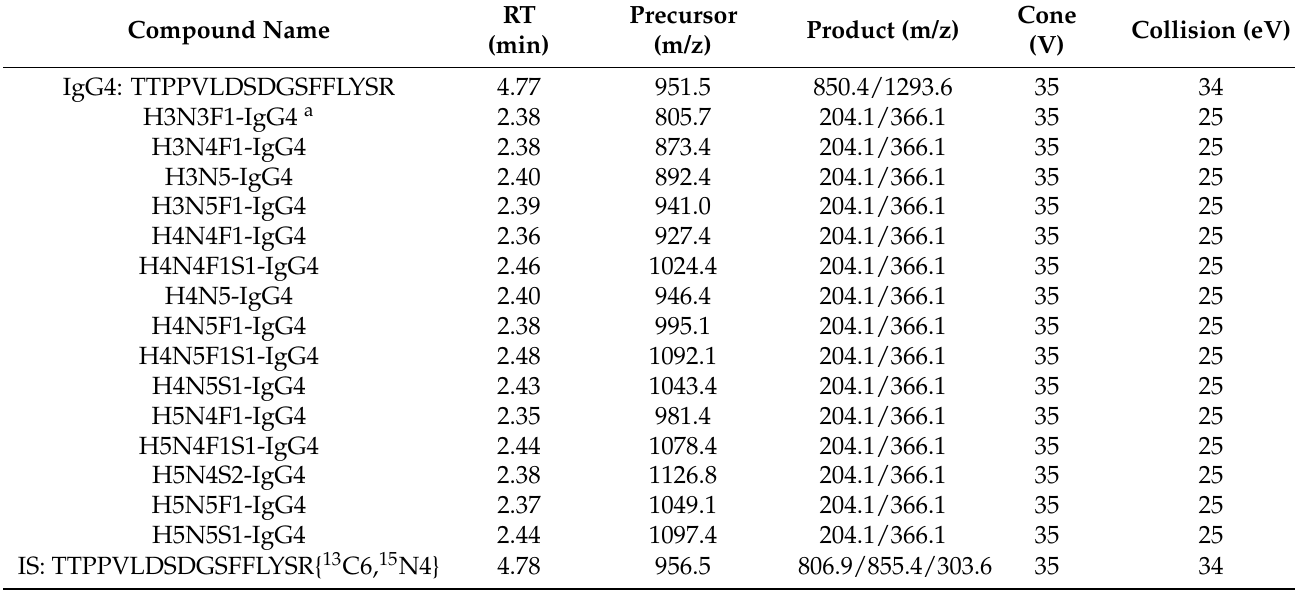
Table 1. MRM transitions and parameters for the IgG4 surrogate peptide, glycopeptides, and the internal standard. Compound Name